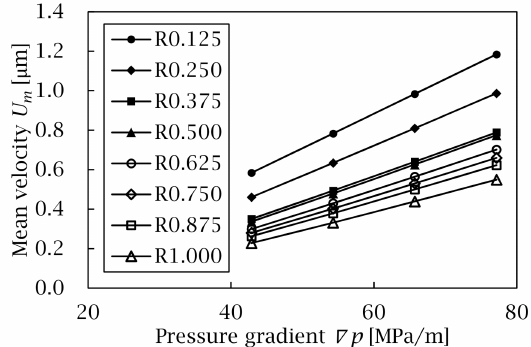
Figure 12. Numerical results for Bingham fluid flow simulation at varying pressure gradient ∇ p and resolution R . The sample size is N = 1000 and resolution ratio changes from R = 1.0 to R = 0.125. The index R in the figure represents the resolution ratio.